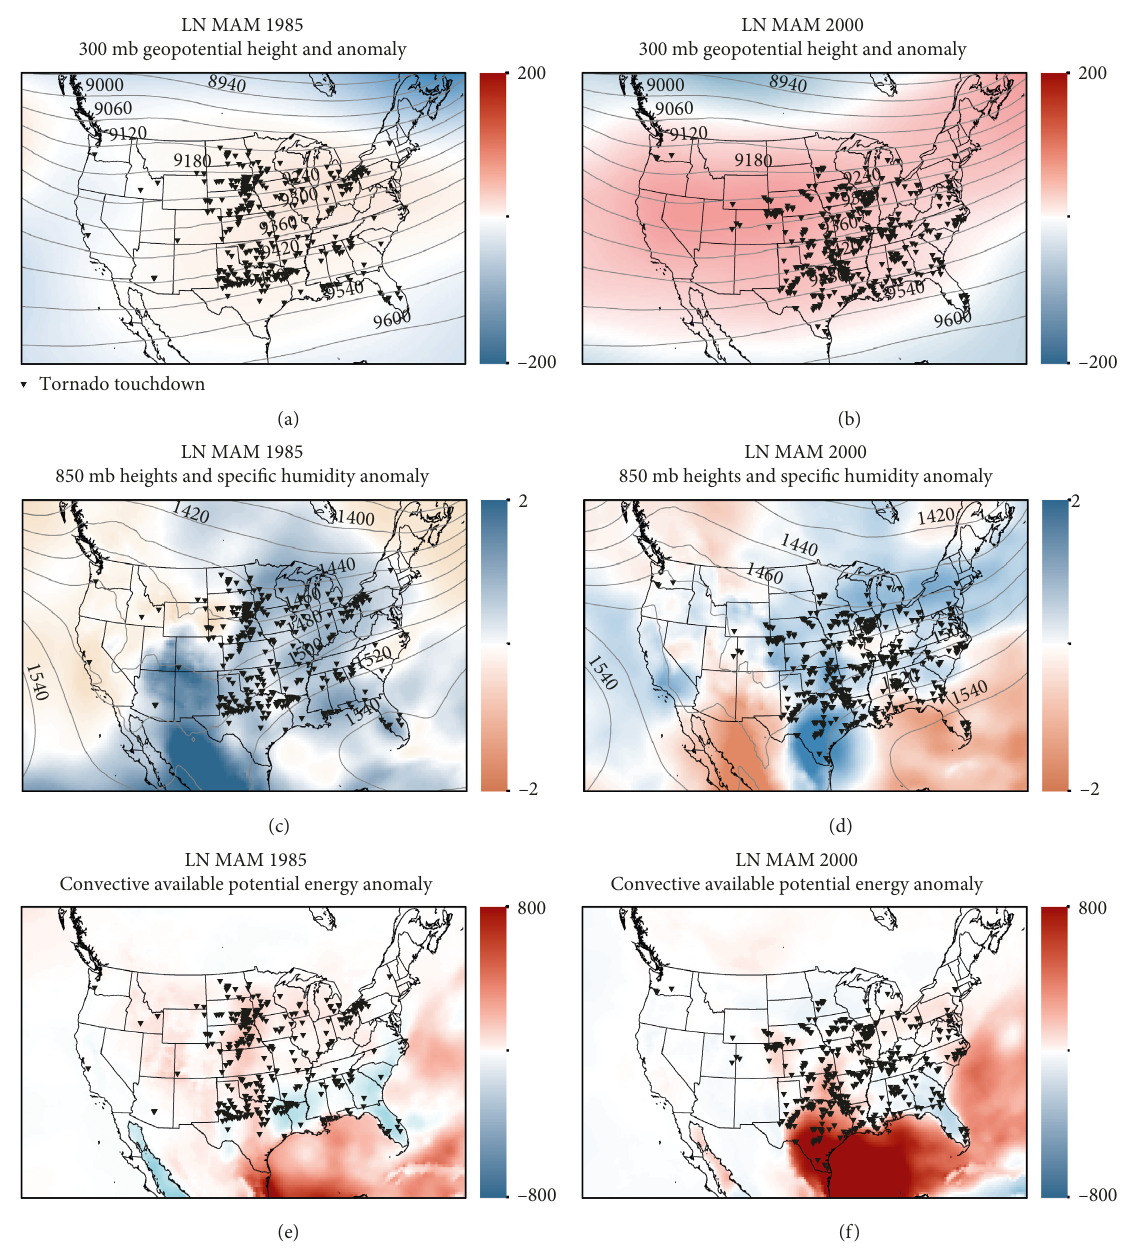
Figure 8: (a, b) 300mb geopotential heights (contours (m)) and anomalies (color (m)), (c, d) 850 mb geopotential heights (contours (m)) and specific humidity anomalies (color (g